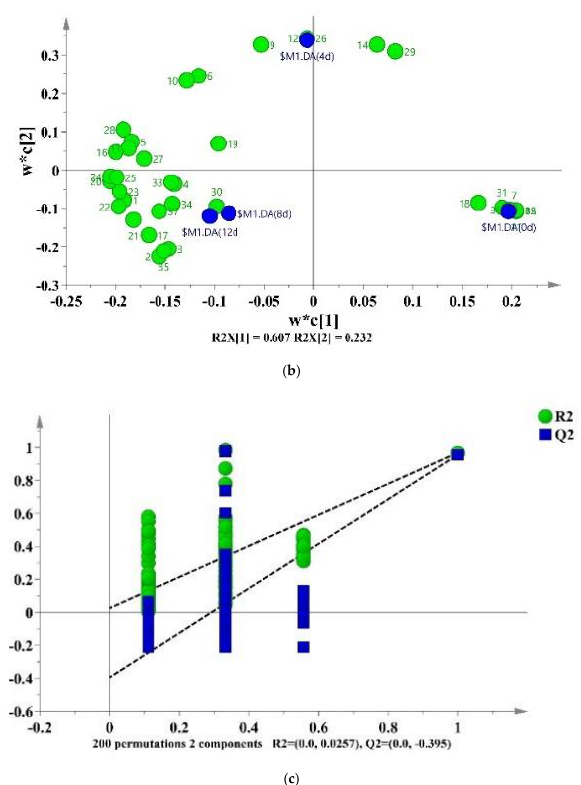
Figure 6. PLS-DA score plot ( a ), loading plot ( b ) and a permutation test at 200 times ( c ) of vacuum- packaged peeled potato samples during storage.